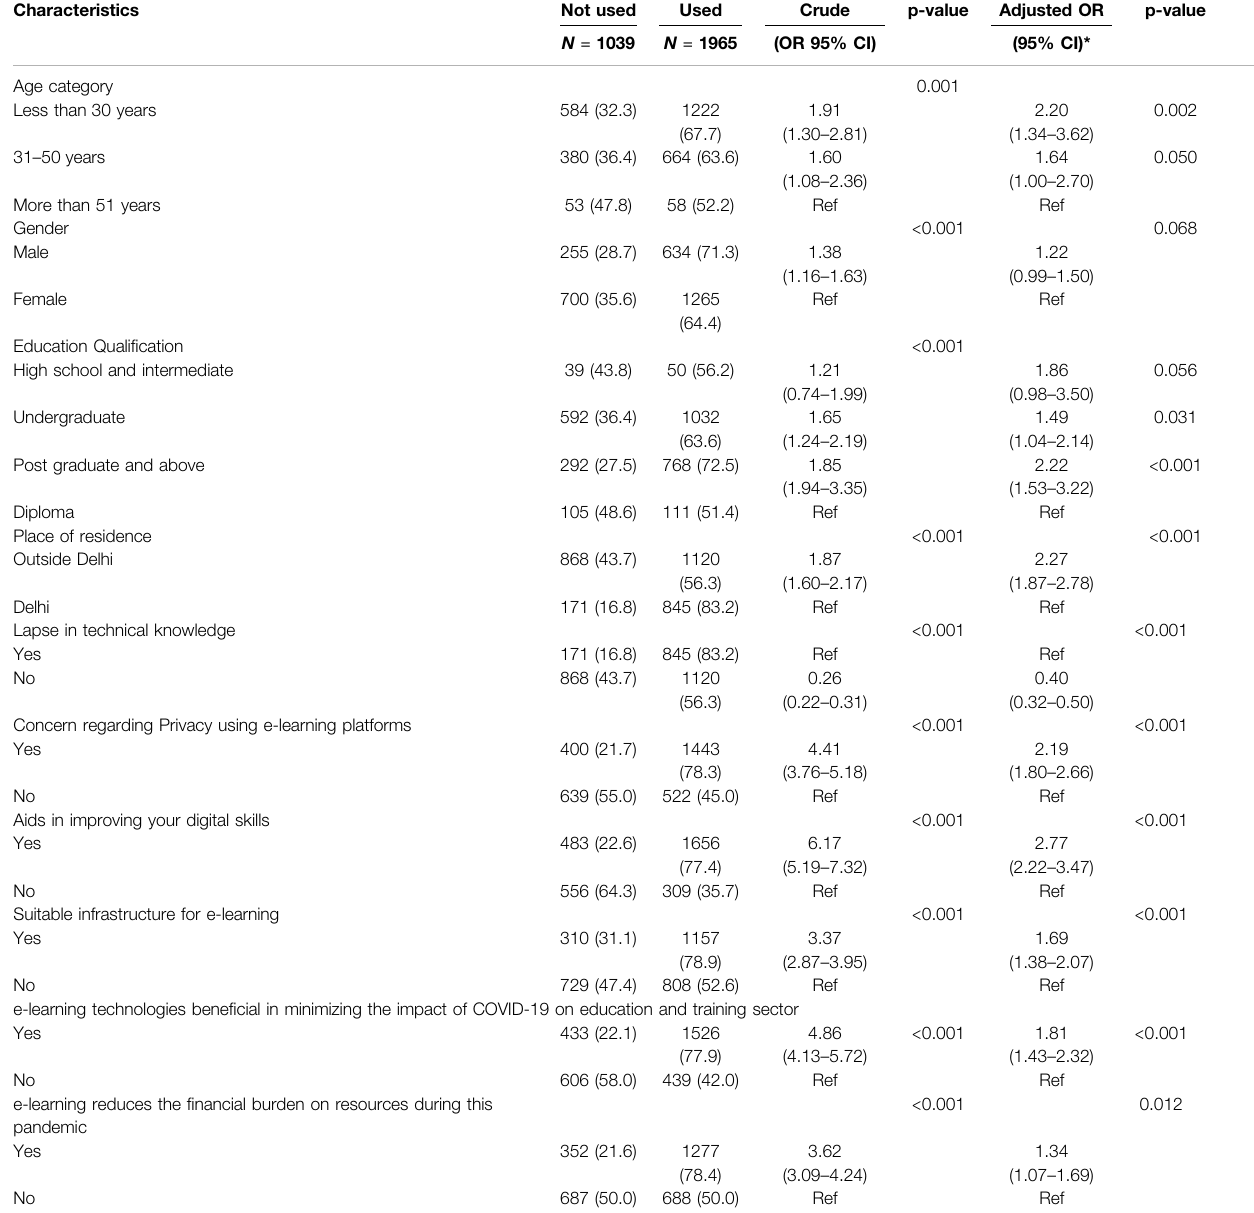
TABLE 3 | Univariate and multivariate analysis assessing the factors affecting use of e-learning.